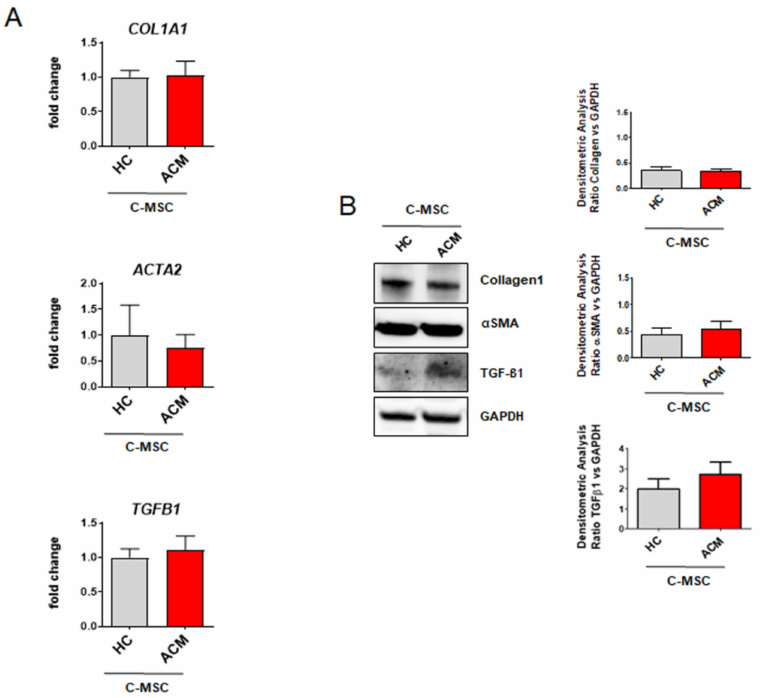
Figure 2. Analysis of fibrotic markers in ACM C-MSC. ( A ) COL1A1, ACTA2, TGFB1 gene expression in total RNA extracts of cardiac mesenchymal stromal cells isolated from HC donors and ACM patients in culture condition. GAPDH was used as a house-keeping gene and qRT-PCR data are presented as the fold change of target gene expression respect to HC C-MSC. n = 7/group. Student’s t -test: no significant difference. ( B ) Western blot analysis of Collagen1, α SMA, and TGF- β 1 proteins in total extracts of cardiac mesenchymal stromal cells isolated from HC donors and ACM patients in culture condition. Quantification of the protein abundance relative to GAPDH is shown in the graphs. n = 4/group. Student’s t -test: no significant